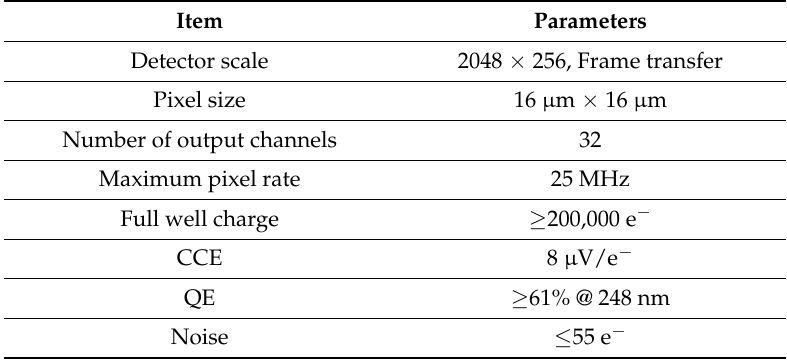
Table 4. Parameters of the CCD detector.